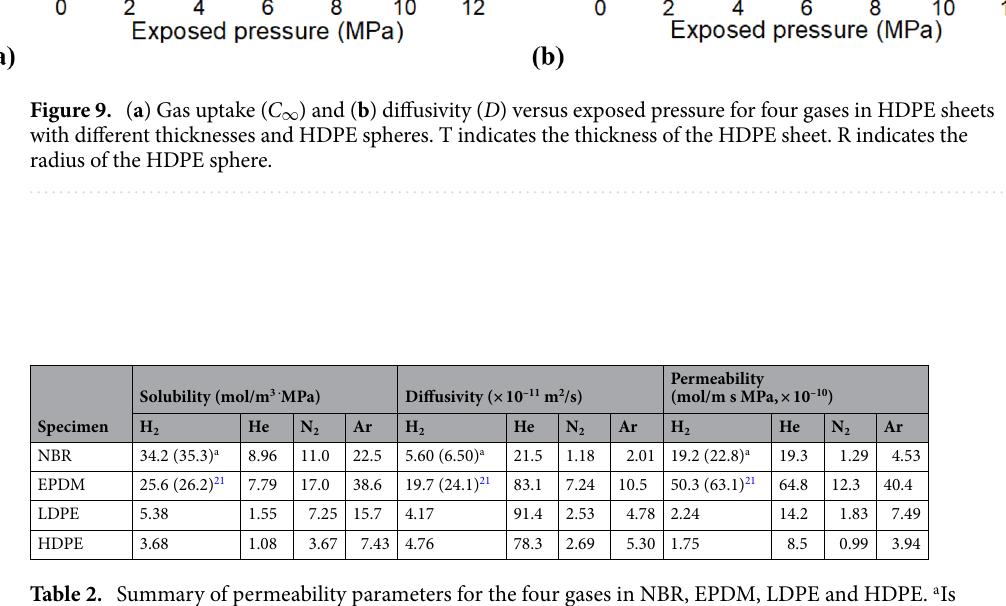
Table 2. Summary of permeability parameters for the four gases in NBR, EPDM, LDPE and HDPE. a Is determined by differential pressure